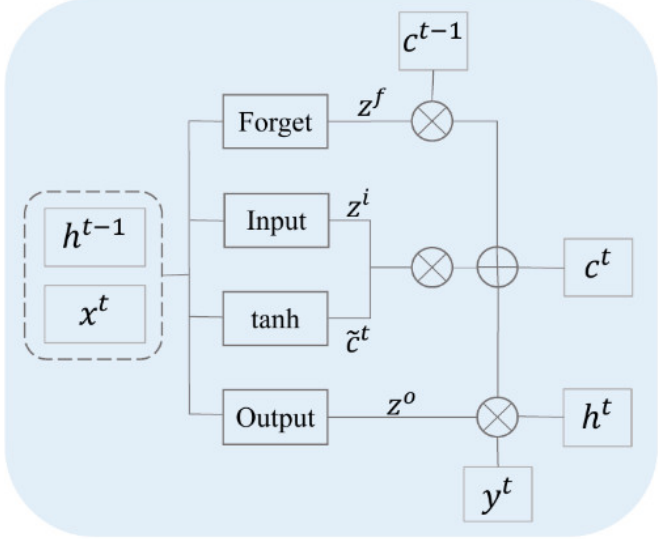
Figure 3. The cell structure of LSTM.